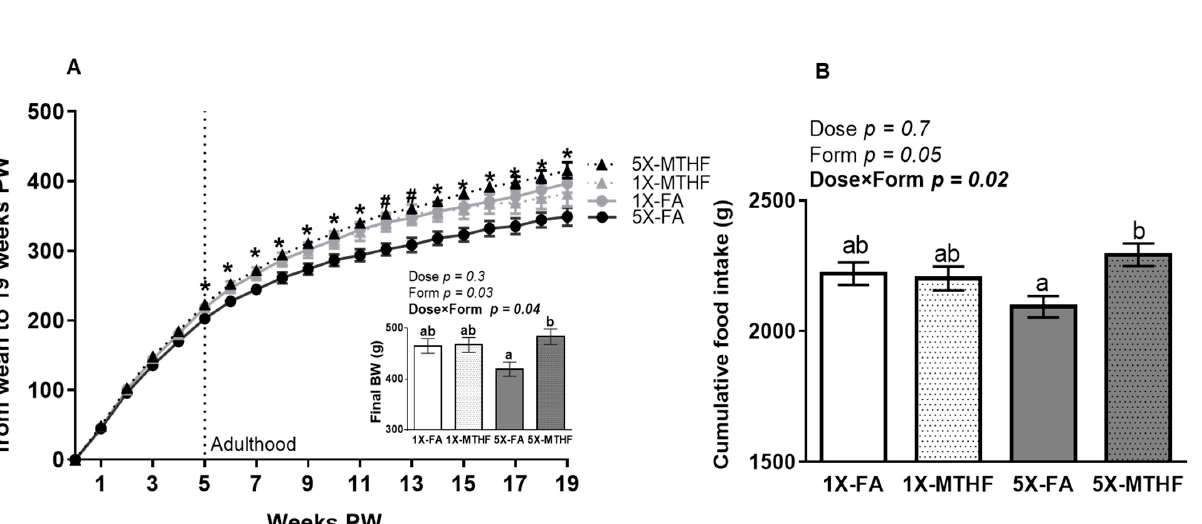
Figure 2. Percent ( A ) visceral adipose, ( B ) liver, and ( C ) total liver fat as adjusted per gram of final body weight in female offspring fed a high-fat diet for 19 weeks post-weaning. Values are least square Mean ± standard error of the mean (S.E.M.), n = 10-12/group. Analyzed by Two-way ANOVA with Dose (1X or 5X) and Form (FA vs. MTHF) as main factors and a Dose×Form interaction term. Significant at p < 0.05. Values in bold indicate significant effects. Abbreviations: AIN-93G rodent diet with either 1X-FA, recommended folic acid (2mg/kg diet); 5X-FA (10mg/kg diet); 1X-MTHF, equimolar recom- mended [6S]-5-methyltetrahydrofolic acid calcium salt (2.1mg/kg diet); or 5X-MTHF (10.4mg/kg diet). 3.2. X offspring have Higher Plasma Leptin at Birth and at 19 Weeks Post-Weaning than 1X Offspring At birth and at 19 weeks post-weaning, plasma leptin concentrations were affected by folate dose (Dose p < 0.05), but not by form nor an interaction. Both forms of the 5X gestational diets led to offspring with higher plasma leptin at birth that was also higher until 19 weeks post-weaning (Table 1). As maternal circulating leptin contributes to fetal plasma leptin levels [38], a correlation analysis between plasma leptin at birth in the